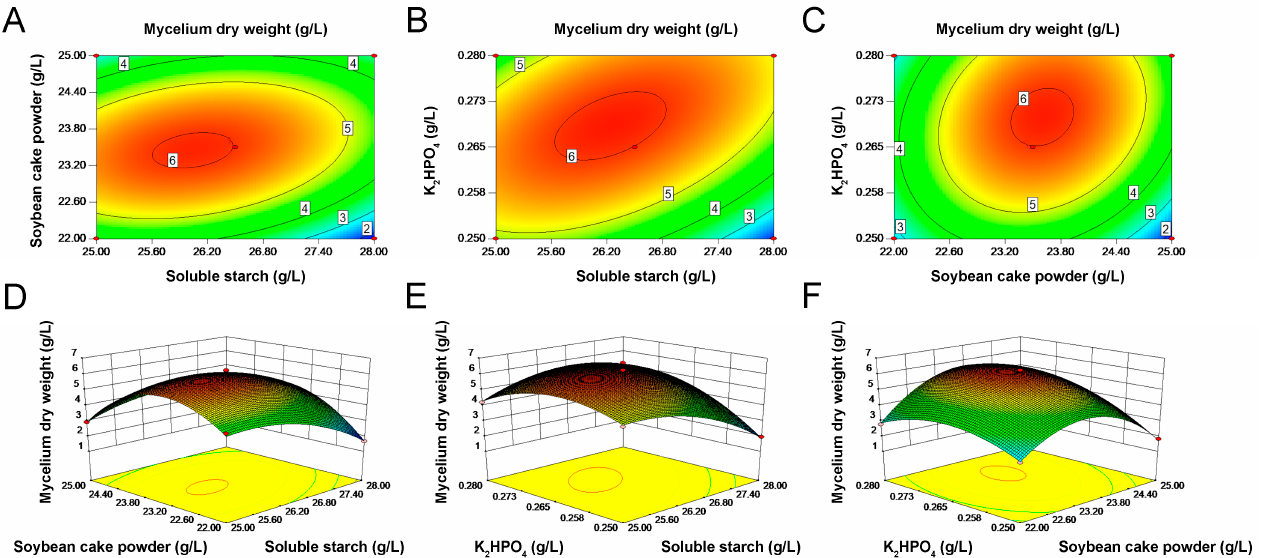
Figure 3. Contour plot described by the model on mycelial dry weight. ( A ) Effect of soluble starch and soybean cake powder. ( B ) Effect of soluble starch and K 2 HPO 4 . ( C ) Effect of soybean cake powder and K 2 HPO 4 . Response–surface curve of mycelial dry weight showing mutual interactions. ( D ) Soluble starch and soybean cake powder. ( E ) Soluble starch and K 2 HPO 4 . ( F ) Soybean cake powder and K 2 HPO 4 . Other variables, except for the two in each figure, were maintained at zero level in coded units. The numbers 2–6 in the figure indicate the mycelium dry weight at this location.